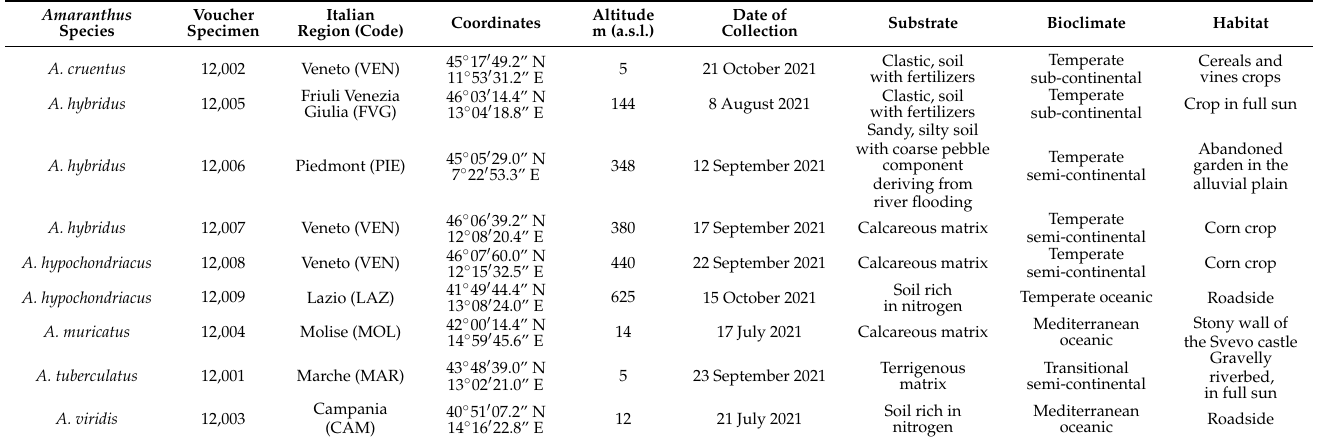
Table 1. List of the collected specimens. Bioclimate is based on